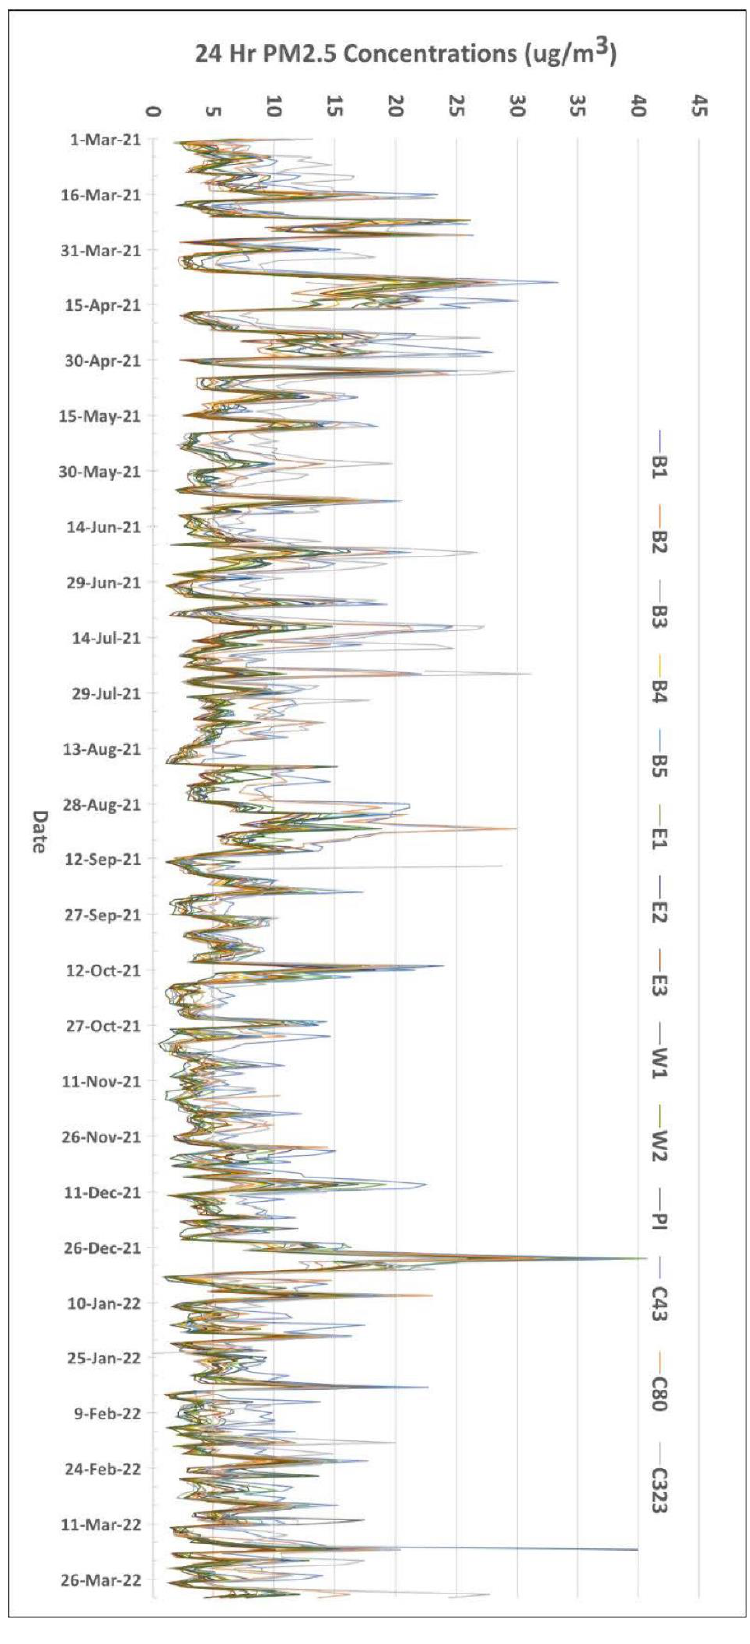
Figure 5. Time series of 24 h PM 2.5 concentrations ( µ g/m 3 ) from the LCSs and TCEQ